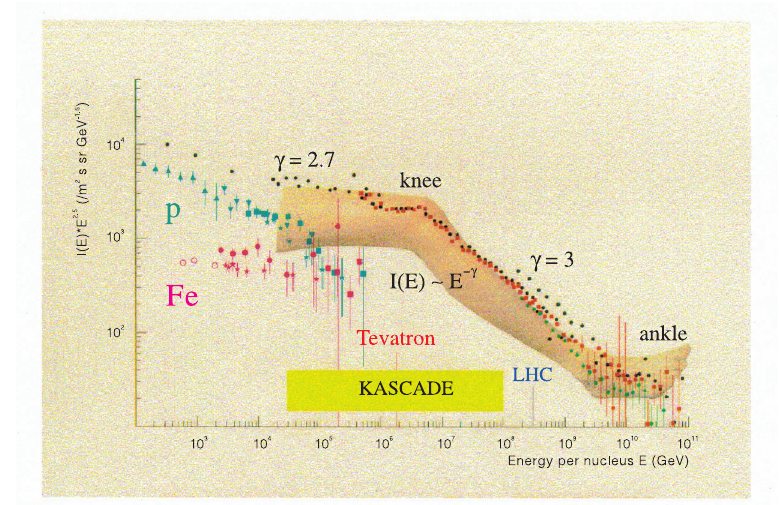
Fig. 2. The cosmic ray energy spectrum: anthropomorphic